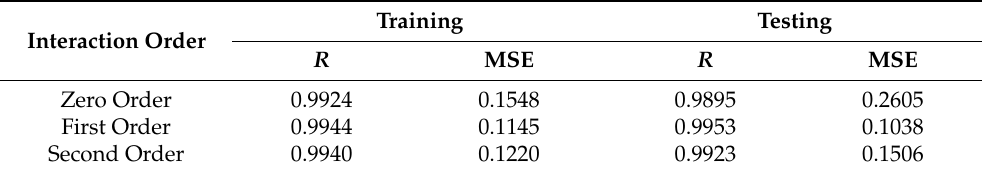
Table 8. Results of Different MARS Models.